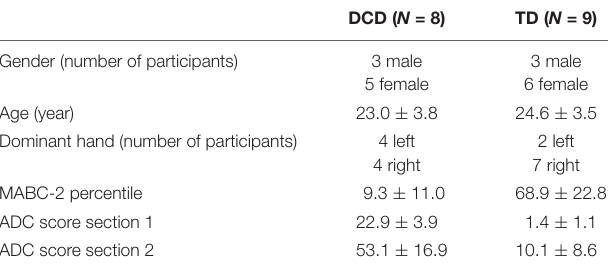
TABLE 1 | Summary of the participant’s characteristics (mean ±